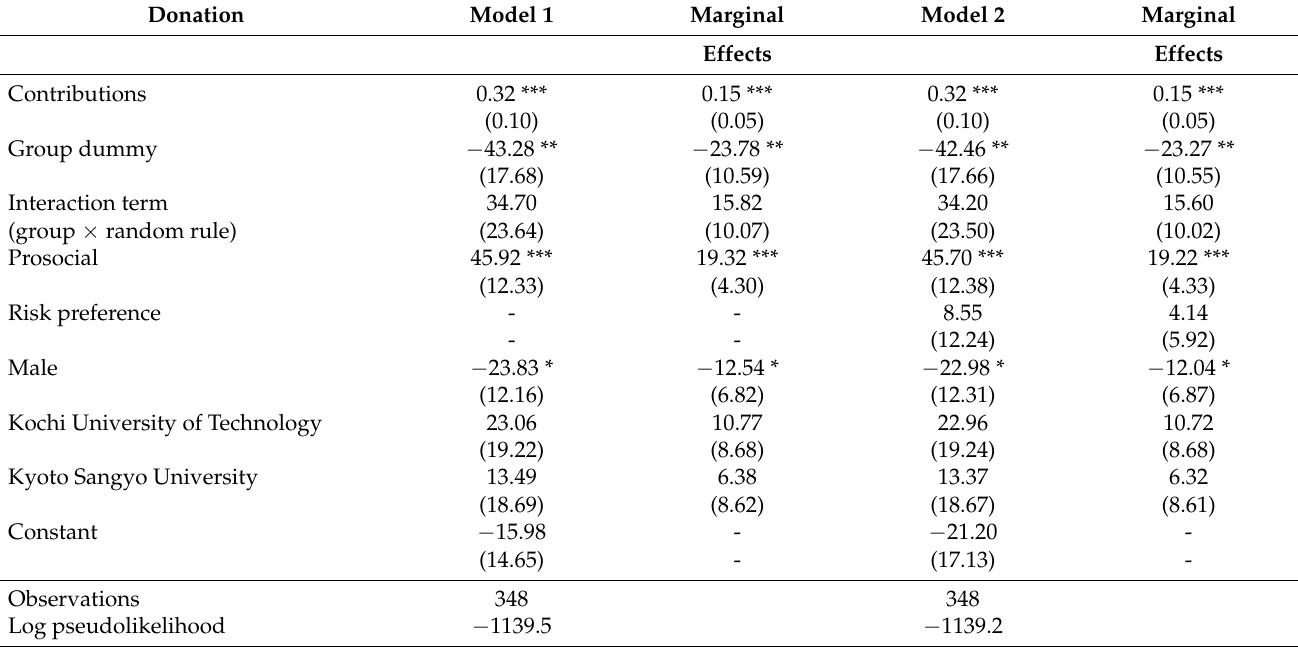
Table 6. Estimation results: Donation (Tobit